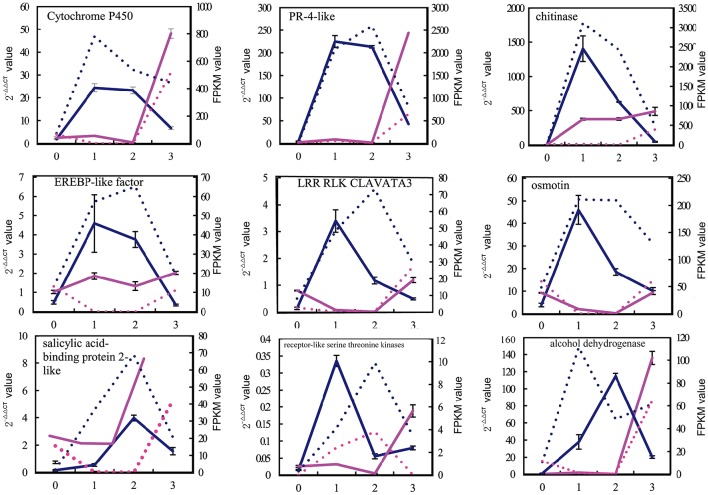
Verification of the expression profiles of 9 pairs of unigenes by qPCR. In total, 30 candidate genes were chosen to validate using qPCR from among the different k-means clusters in V. fordii and V. montana (Supplemental Figure S4). The results of qPCR were generally in accordance with the gene expression profiles in the transcriptome data. X-axis represented the different stage of F. oxysporum infection. 0, the stage before infection; 1, the early stage of infection with F. oxysporum; 2; the middle stage of infection with F. oxysporum; 3, the late stage of infection with F. oxysporum. The left Y-axis represented the expression level (2−ΔΔCT value) of genes. The right Y-axis represented the expression level of genes according to the FPKM value. The blue solid line represented the expression level (2−ΔΔCT) of genes in V. montana (M) using qPCR; the blue dotted line represented the expression level of genes in V. montana (M) according to the FPKM value; the red real line represented the expression level (2−ΔΔCT) of genes in V. fordii (F) using qPCR; the red dotted line represented the expression level of genes in V. fordii (F) according to the FPKM value.